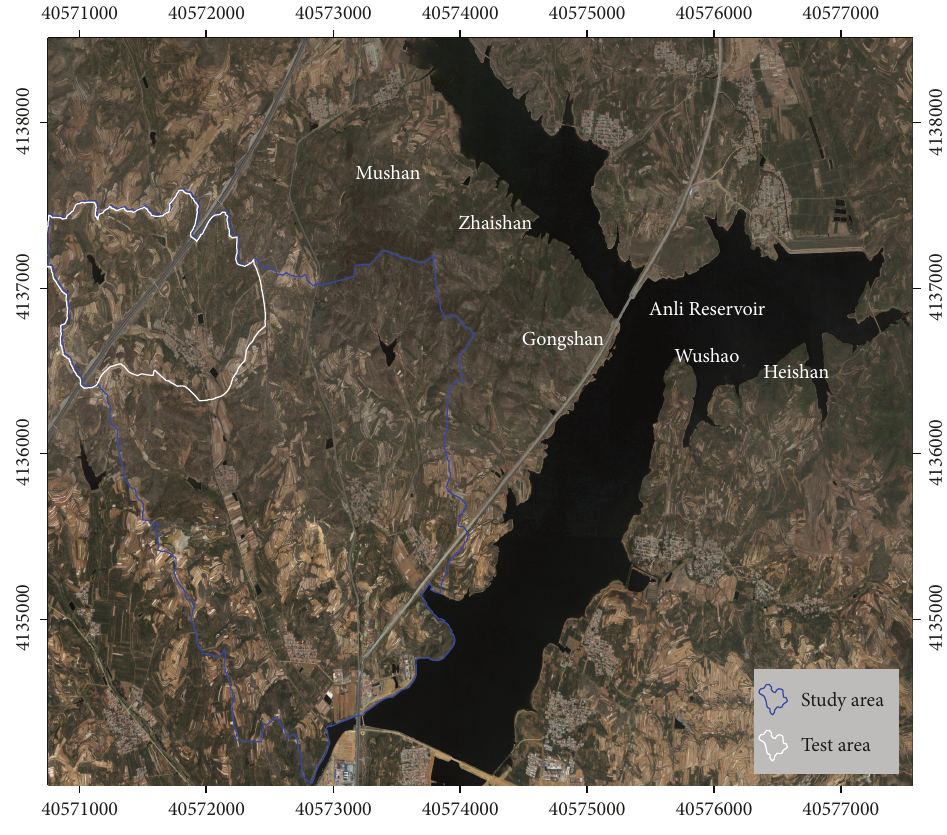
Figure 1: Location of the Qixia study area on a Quickbird true color